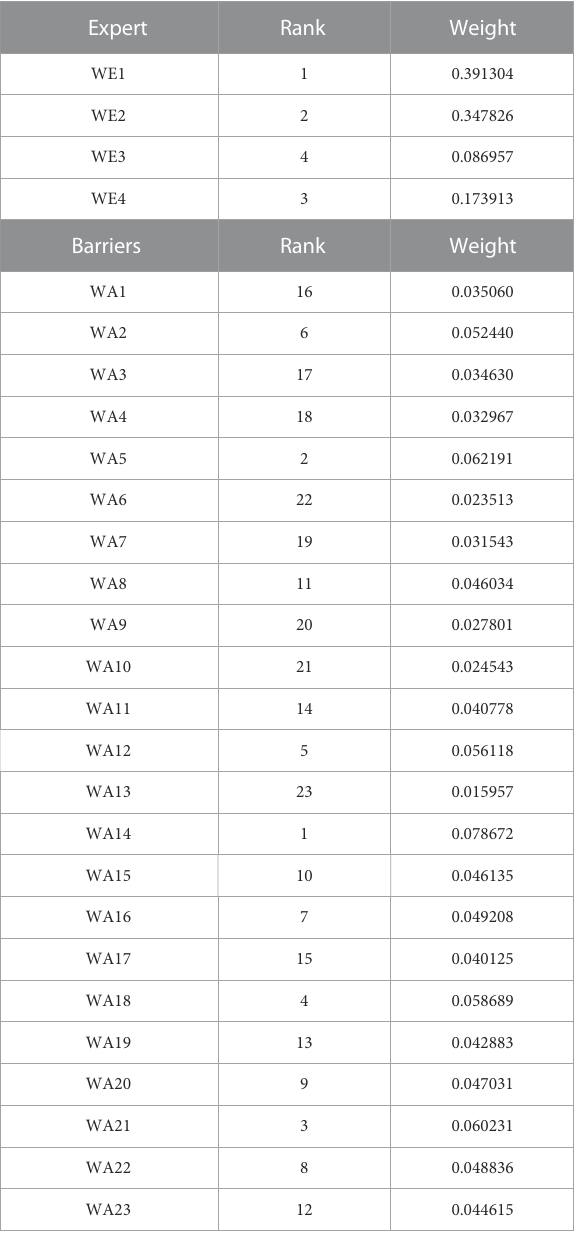
TABLE 4 Weight of barriers (Source: Author).